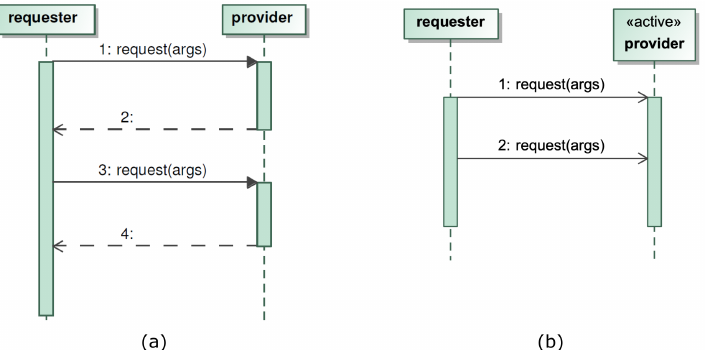
Figure 23. Synchronous and asynchronous handling of requests without using enhanced connectors: ( a ) Synchronous handling of requests. ( b ) Asynchronous handling of requests.